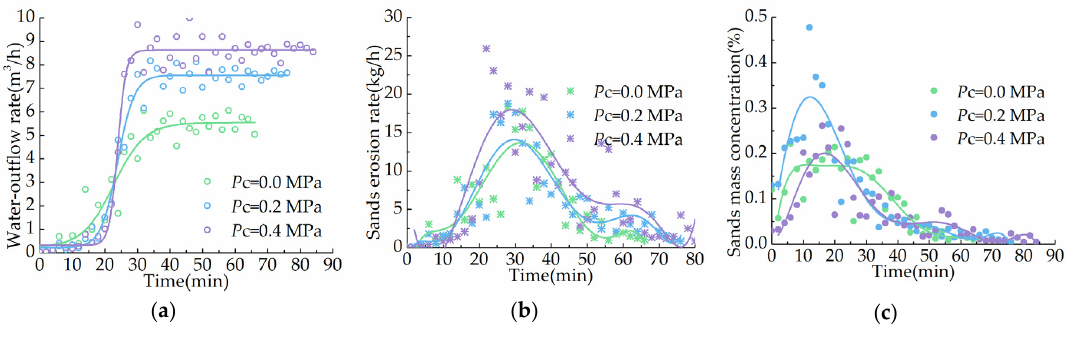
Figure 13. Variation curve of monitoring objects with confining pressure ( P c ). ( a ) Variation of water-outflow rate with confining pressure; ( b ) Variation of sands erosion rate with confining pressure; ( c ) Variation of sands mass concentration with confining pressure. Table 9. Variation of monitoring objects’ characteristic value with confining pressure ( P c ).